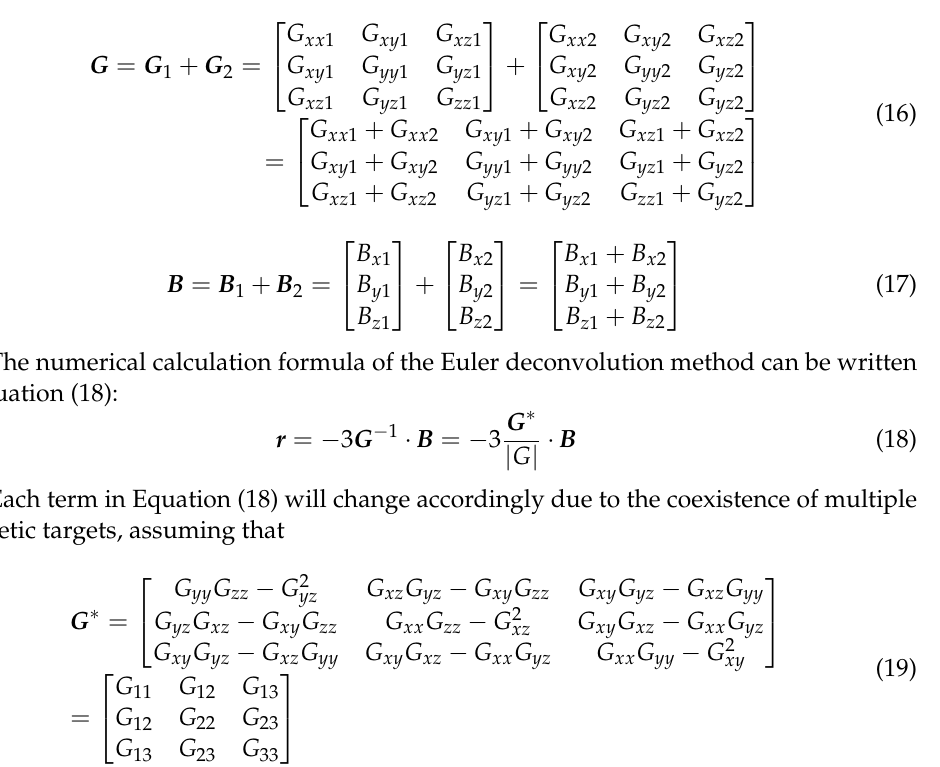
Figure 6. The mean value of the MSE for 100 groups of random trajectory tracking.